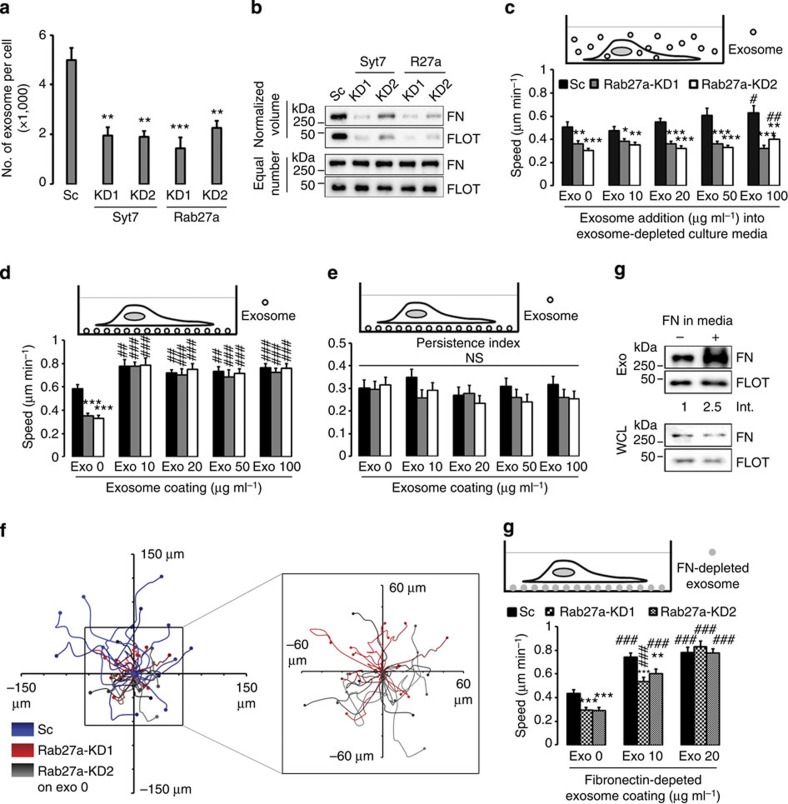
Exosome secretion promotes cell migration.(a) Average number of exosomes secreted from endolysosomal secretion-inhibited HT1080 cell lines from n≥3 experiments. (b) Western blots of exosome cargos. FLOT, flotillin. (c) Migration speed of Rab27a-knockdown (KD) HT1080 cells in exosome-depleted media±add-back of purified exosomes (Exo), as indicated on tissue culture-treated plates. (d) Speed of Rab27a-KD cells on exosome-coated plates. (e) Persistence index calculated from experiments shown in d. (f) Wind–Rose plots for data shown in d, Exo 0. Magnification of boxed area is shown at the right. (g) Western blot for FN-depleted exosomes. Numbers below blot represent relative intensity (Int.) of FN (normalized to FLOT) from that blot. WCL, whole-cell lysates; (h) Single-cell migration assays on FN-depleted exosome-coated plates. Error bars, s.e.m., from n≥29 cells for each cell line from three independent experiments. *P<0.05; **P<0.01; ***P<0.001 compared with Sc by Student t-test. #P<0.05; ##P<0.01; ###P<0.001 compared with same cell line on Exo 0 by Student's t-test. NS, not significant.